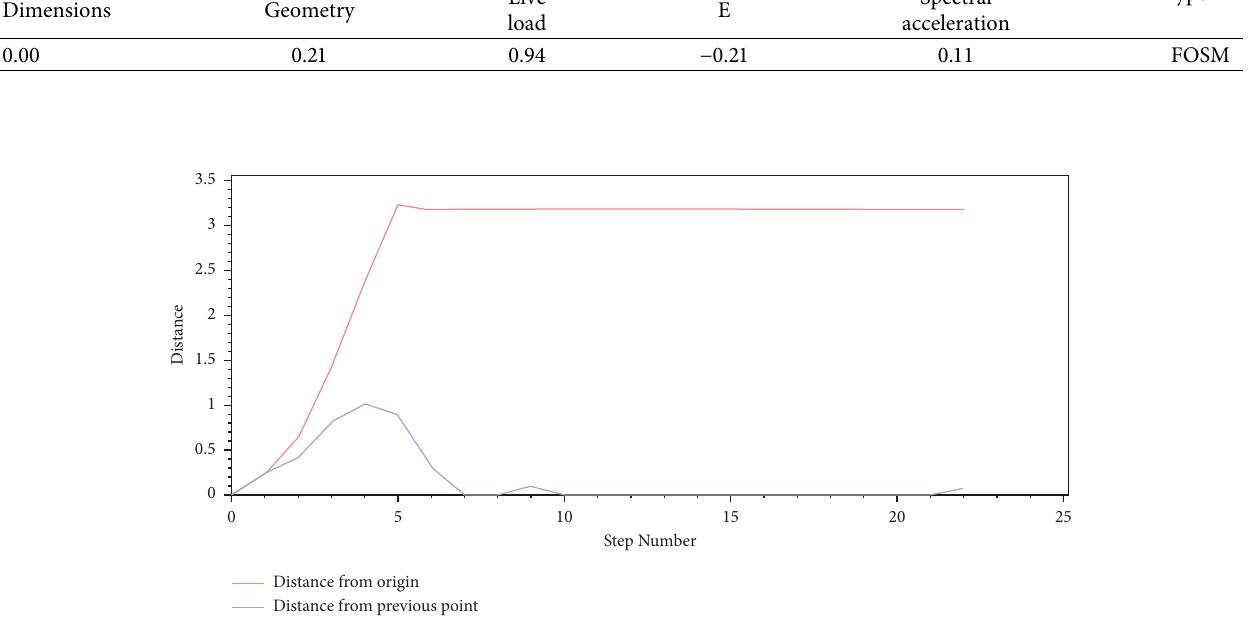
Table 7: Results of the significance scale for uncertainties in FOSM analysis of type III headed frames.